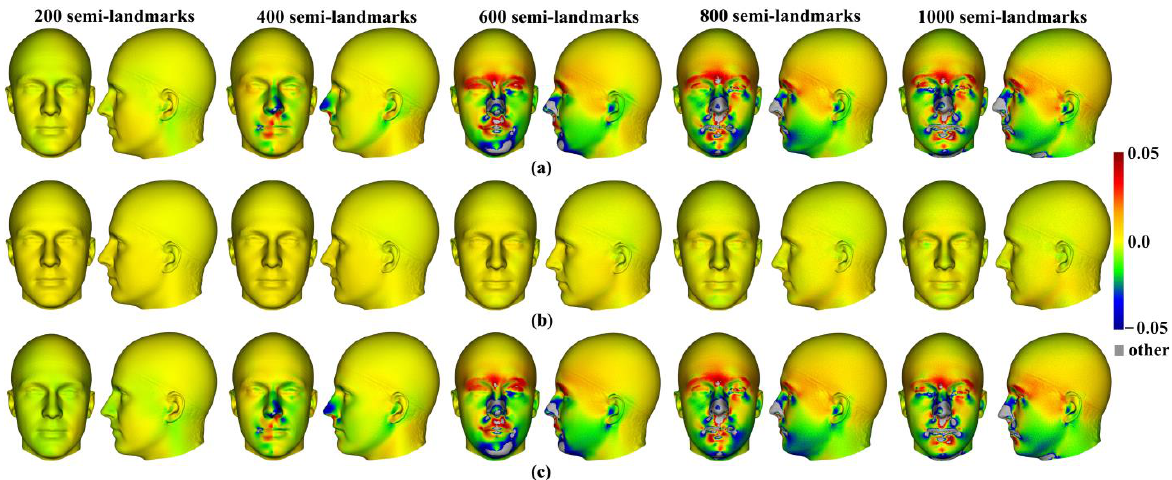
Figure 7. Visualization of the differences in mesh triangle surface areas among mean surface shapes generated using different semilandmarking approaches after re-semilandmarking and re-warping. Differences between ( a ) sliding TPS (reference) and LS&ICP (target) approaches. ( b ) Sliding TPS (reference) and TPS&NICP (target) approaches. ( c ) TPS&NICP (reference) and LS&ICP (target) ap- proaches. Scale bar indicates difference in local area between reference and target surfaces expressed as a proportion of the reference area.